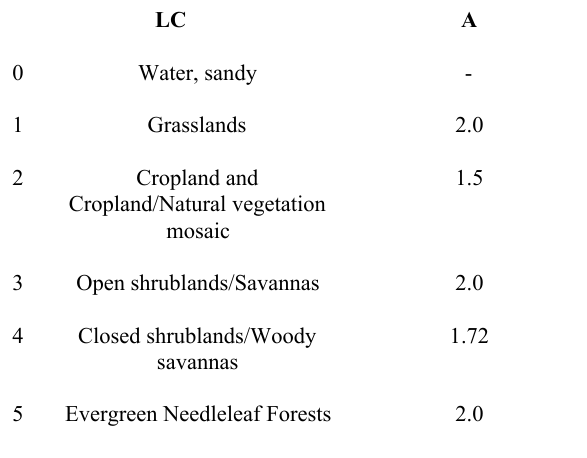
Table 1. The seven land cover (LC) classes and its respective ​ flammability constant (“A”) used in the INPE’s Fire Risk model